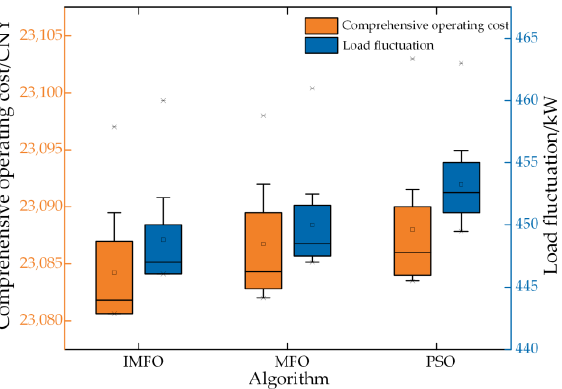
Figure 10. Convergence curves of different algorithms.